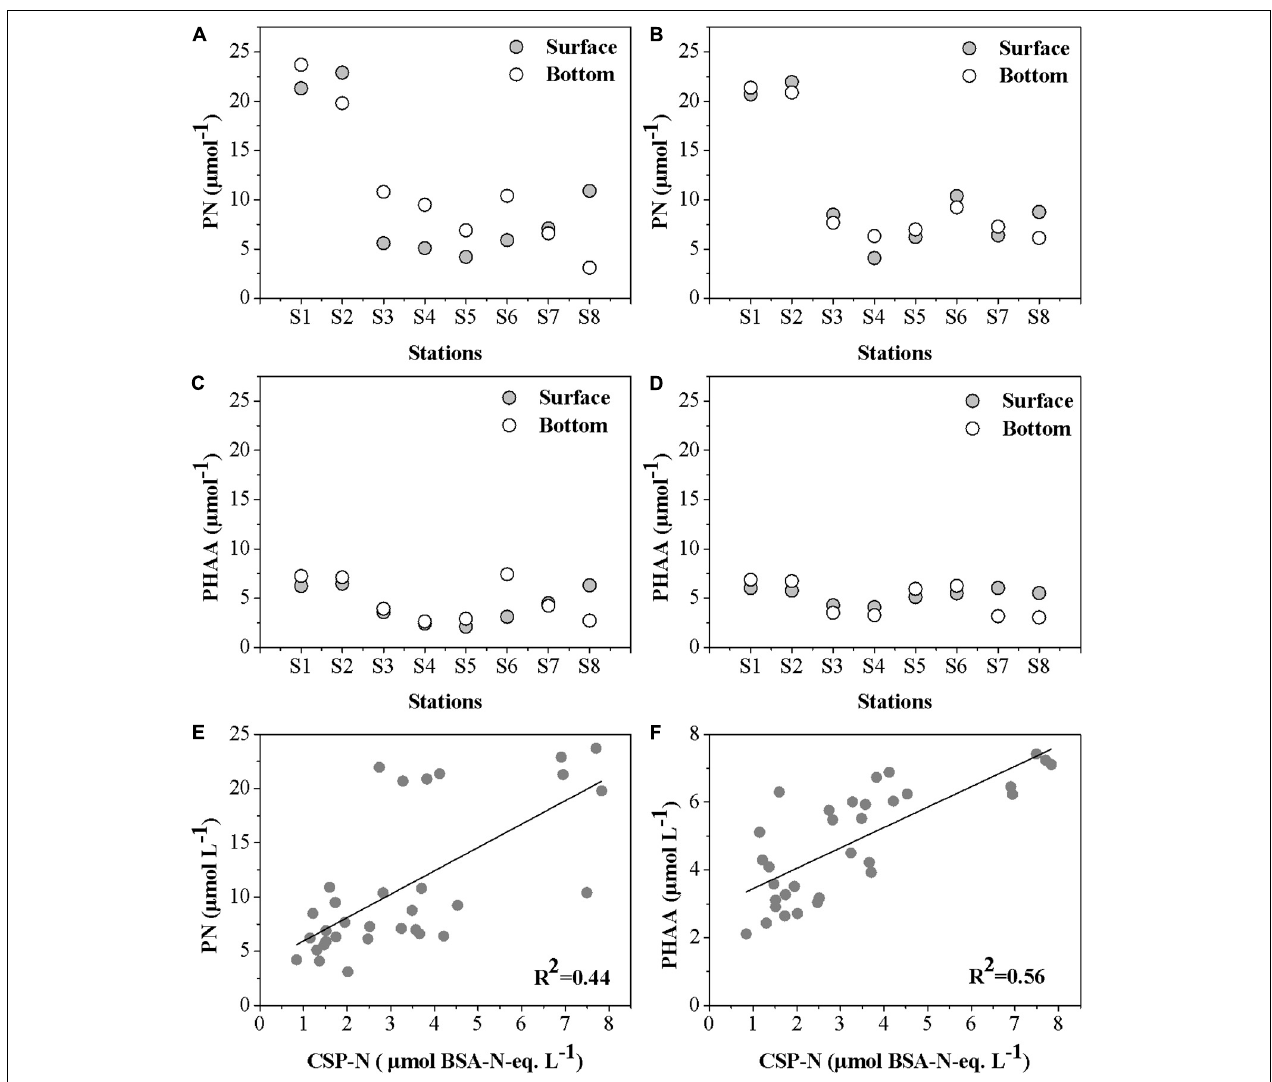
FIGURE 6 | Spatial distribution of PN and PHAA in August 2016 (A,C) and January 2017 (B,D) ; and (E,F) , the relationship between CSP-N concentrations and PN and PHAA in the Pearl River estuary.